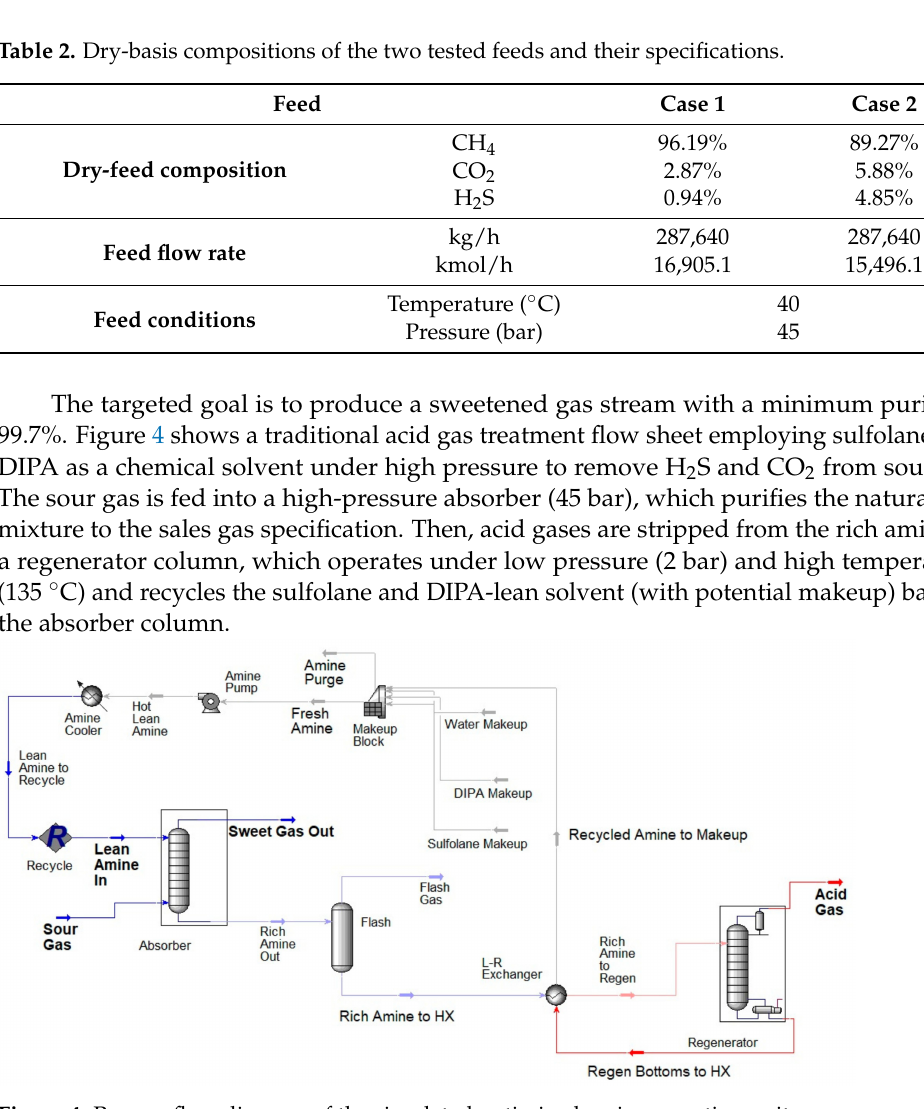
Figure 4. Process flow diagram of the simulated optimized amine-sweeting unit.